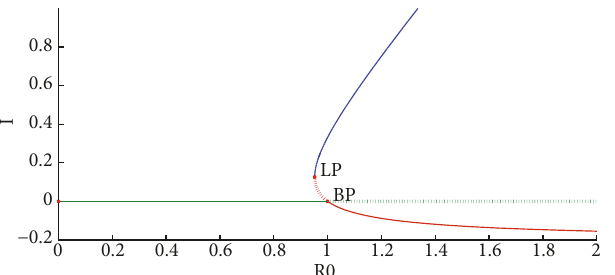
Figure 1: Backward bifurcation diagram of the system. Solid lines indicate stable equilibria; dotted lines indicate unstable equilibria. The vertical axis indicates the size of infected population at